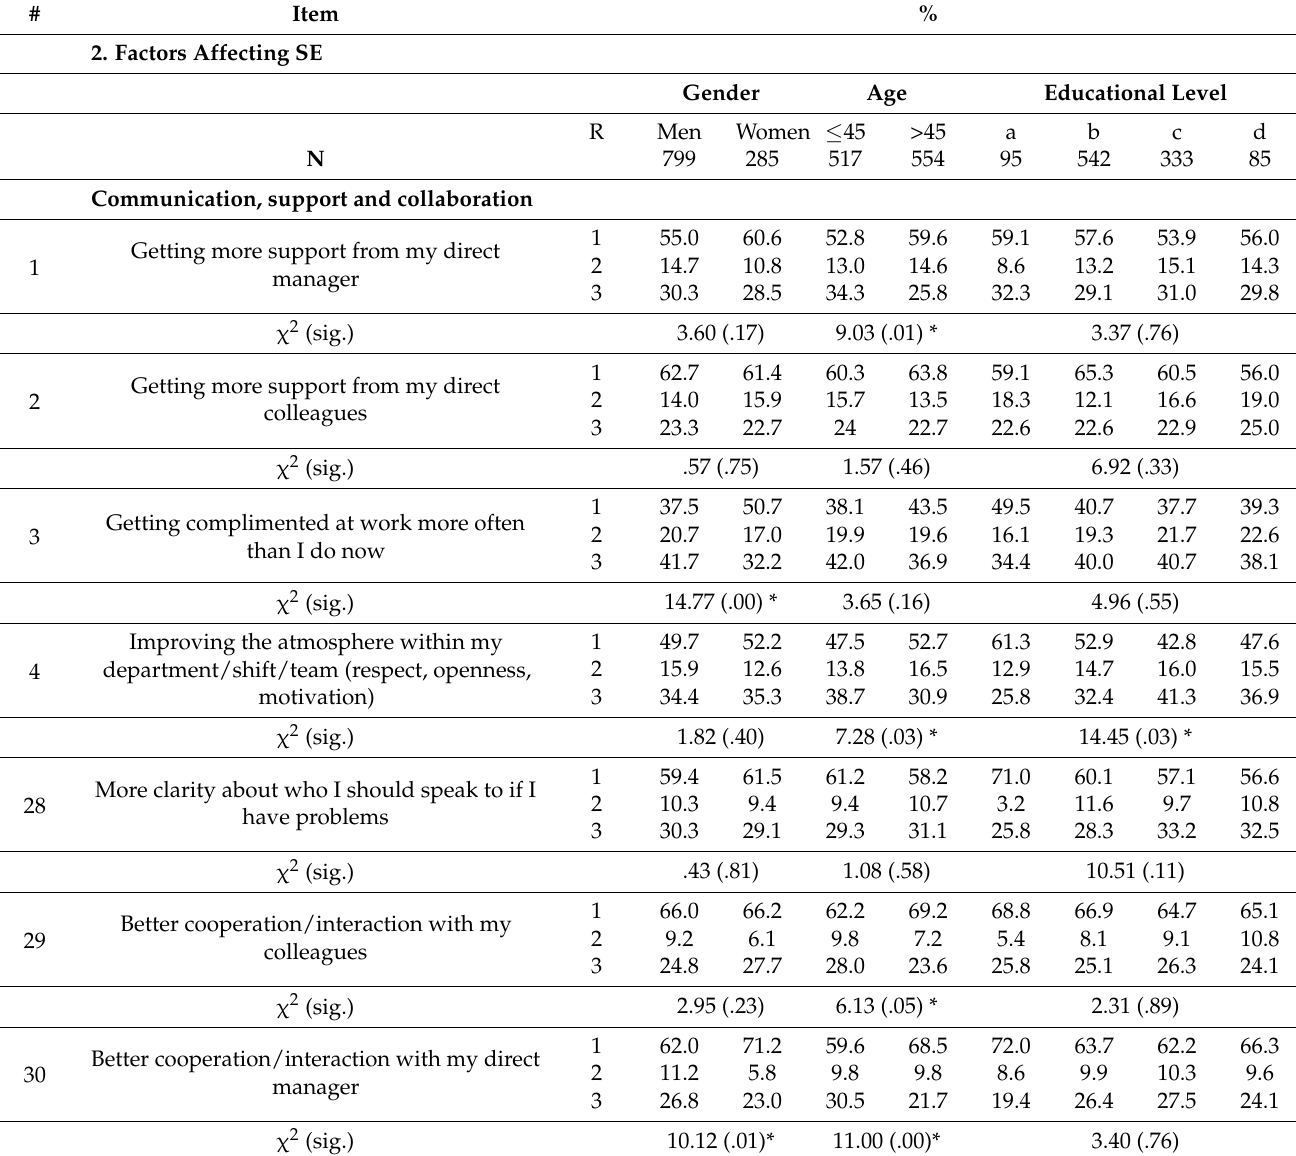
Table A1. Chi-square subgroup analyses (gender, age, educational level) MAISE-Easy Area 2— Factors affecting